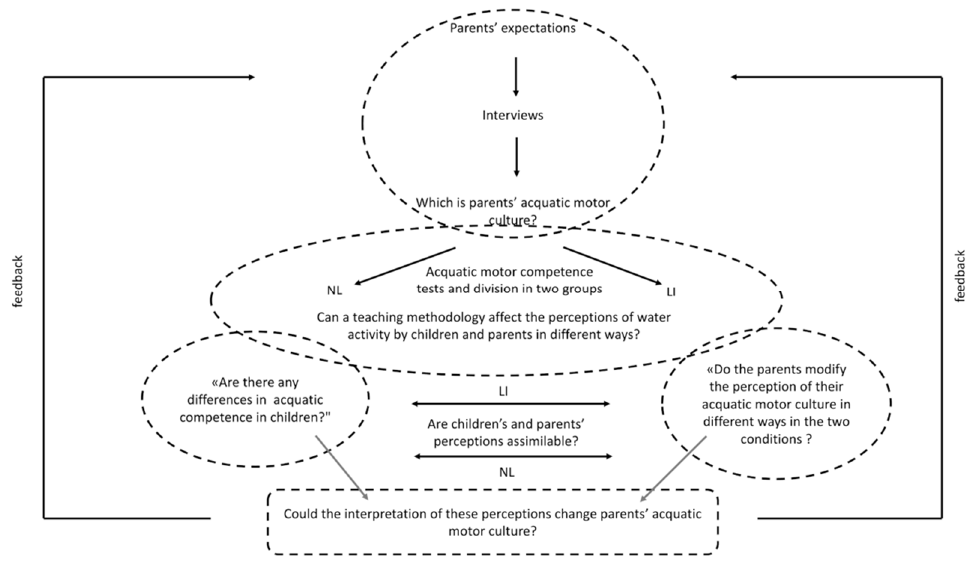
Figure 6. Graphical representation about the fields of investigation of in the research work.